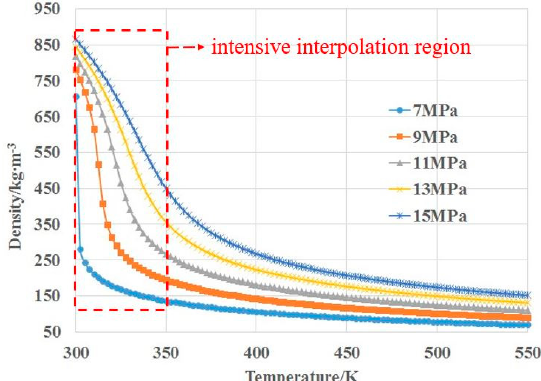
Figure 7. Density variation with temperature and pressure of SCO 2 .